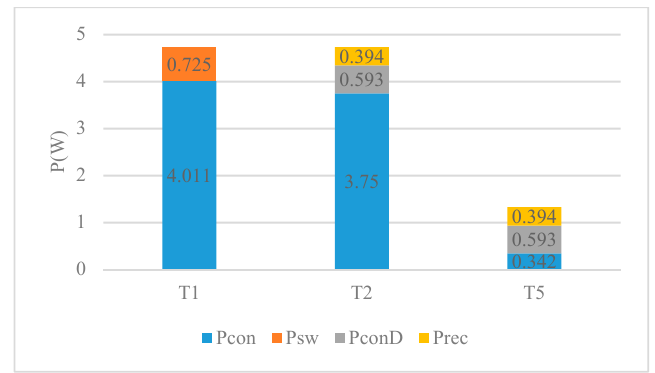
Figure 6. Loss distribution of T1, T2, and T5 in hybrid SiC and Si topology.